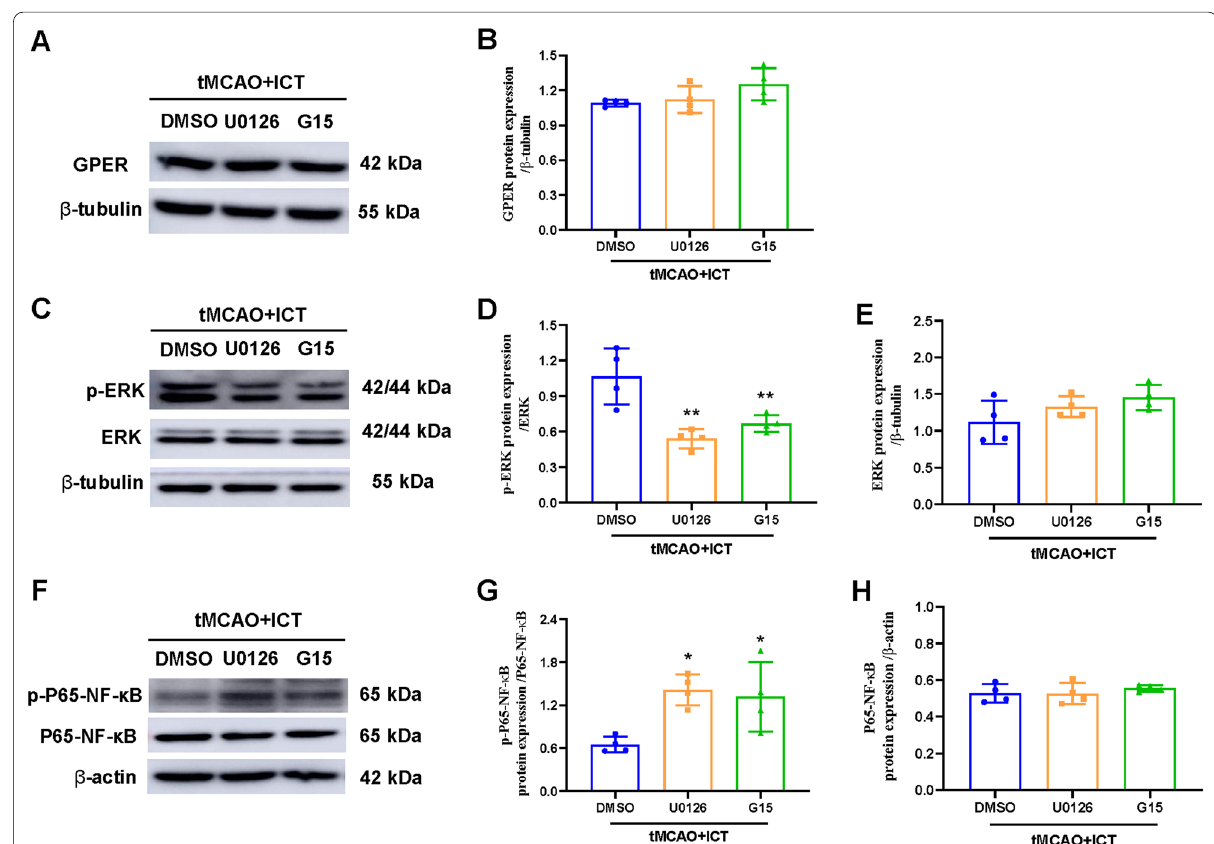
Fig. 8 U0126 and G16 reversed effects of ICT on ERK-NF-κB signaling in CI/RI rats. A – H The protein expression of GPER, p-P65-NF-κB, P65-NF-κB, ERK and p-ERK (n 4). The results are expressed as the mean =